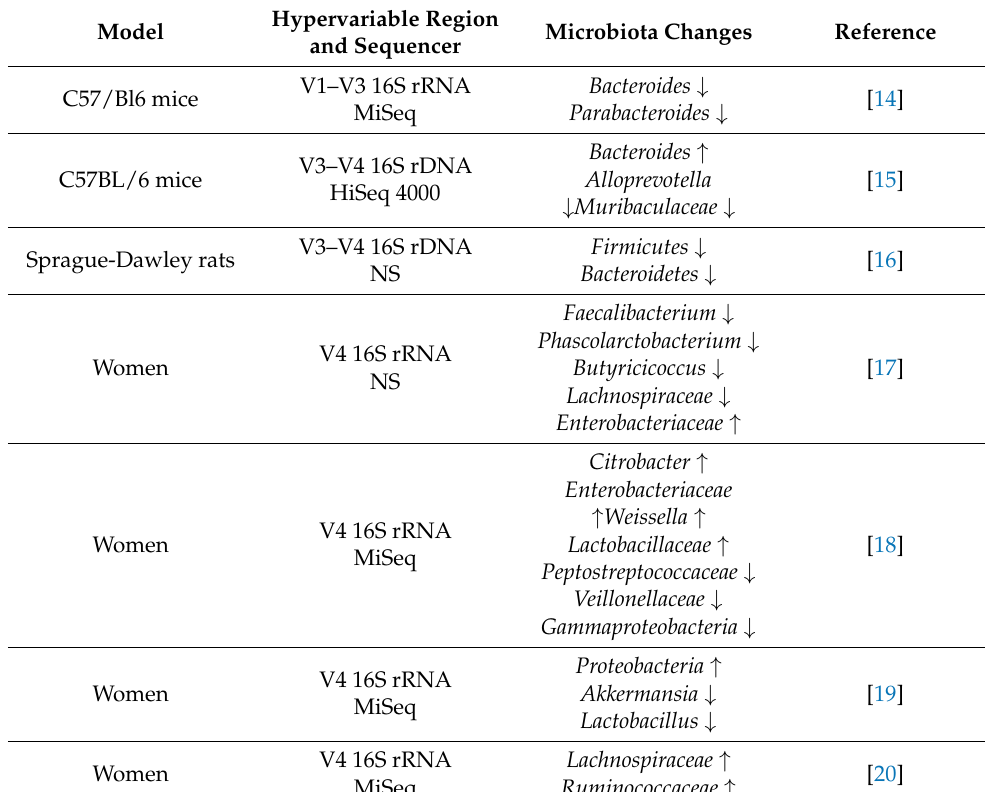
Table 1. Stratification of studies in which are strictly reported changes that occurred in the gut